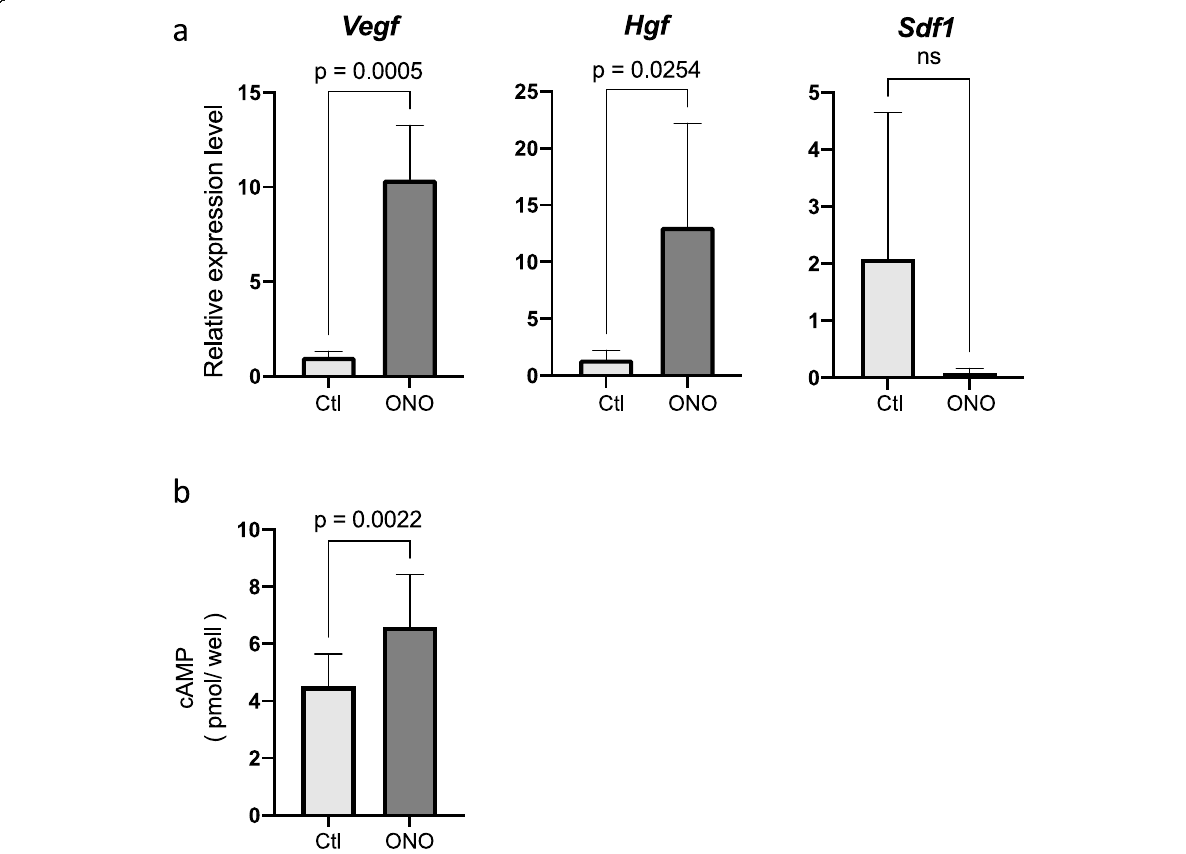
Fig. 6 Effects of ONO-1301 against Human umbilical vein vascular endothelial cells (HUVECs) in vitro. A After addition of ONO-1301 (0.1 μ M) or vehicle to HUVEC cultures, mRNA expression levels of Hgf , Vegf , and Sdf1 were analyzed (each experiment was repeated six times). B cAMP levels of each condition were analyzed of three independent experiments. Data are presented as means ± standard deviations. ns: not